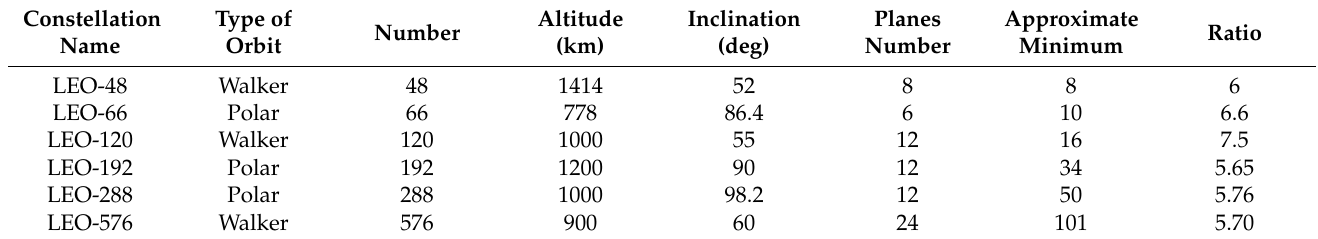
Table 2. Detailed orbital configurations and approximate minimum solution of the designed LEO constellations.